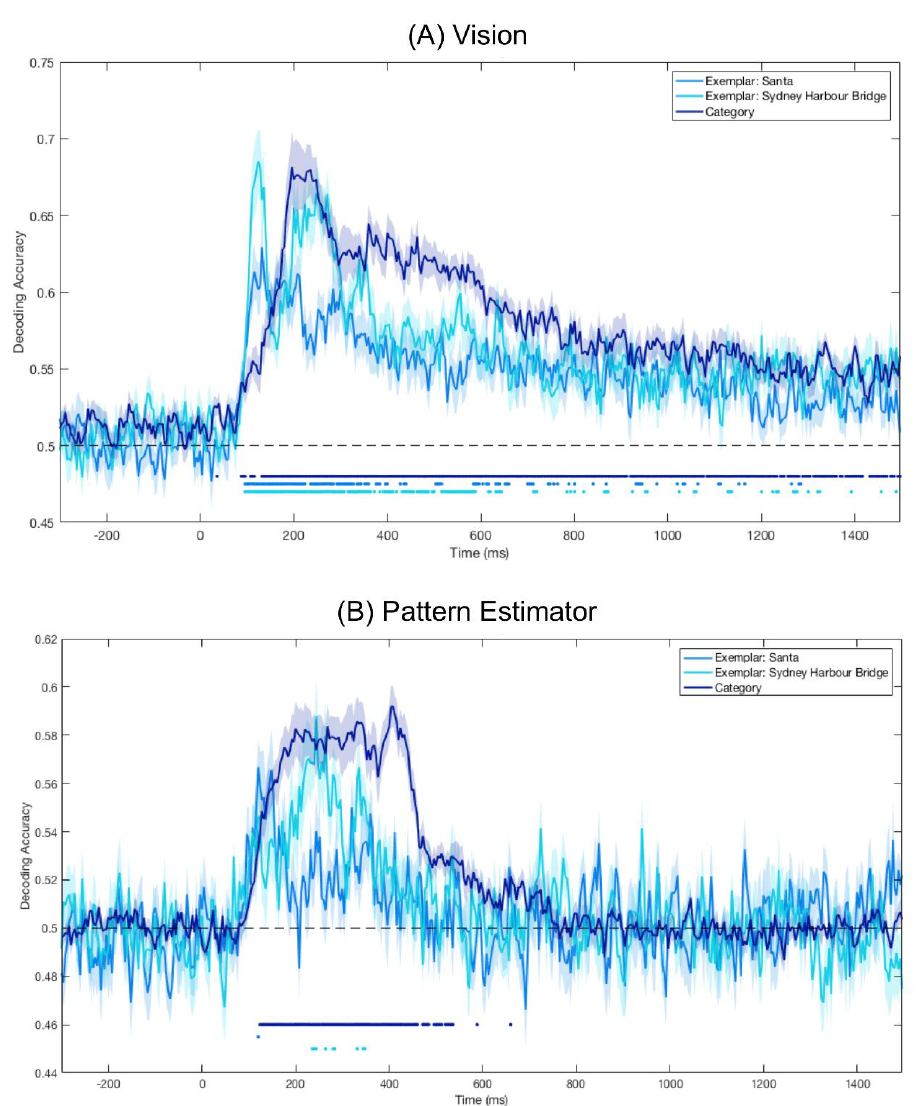
Figure 3. Mean decoding accuracy for Vision ( A ) and Pattern Estimator ( B ) images. Dots below plots indicate time points at which decoding was significantly above chance ( p < 0.05). Shaded areas represent the standard error of the mean across subjects. ( A ) Vision: Decoding category and exemplar identity from the four target images presented in the experimental trials. ( B ) Pattern Estimator: Decoding category and exemplar identity from the 56 images presented in the fast streams at the beginning of each block; category decoding was based on all images in the stream classified by either face or place, and exemplar decoding was based only on the targets and modified